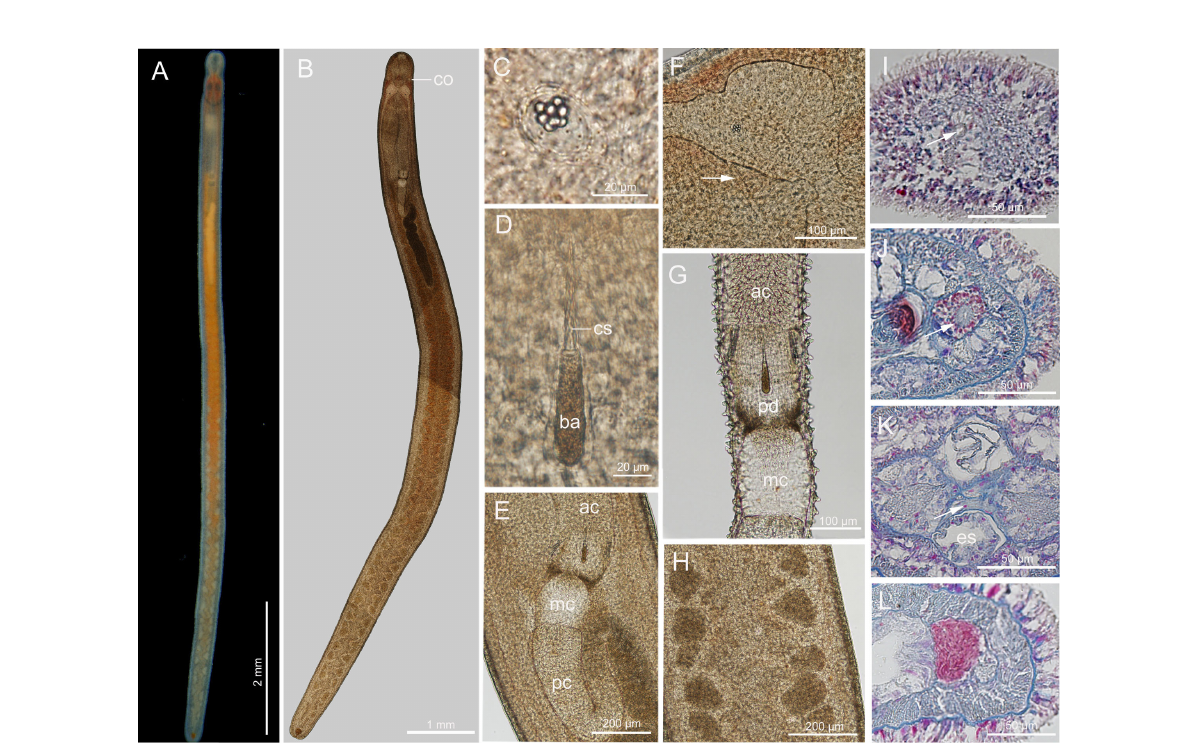
FIGURE 7 Ototyphlonemertes ( Procso ) subrubra sp. nov. (A) Photograph of a live specimen; (B) composite photomicrograph of a squeezed specimen; (C) statolith; (D) central stylet and basis; (E) photomicrograph of partial proboscis from a squeezed specimen; (F) photomicrograph of partial brain from a squeezed specimen, showing the extra ventral commissure (arrowed); (G) everted proboscis; (H, L) testes; (I) transverse section through frontal organ (arrowed); (J) transverse section through a cerebral organ (arrowed); (K) transverse section through cerebral region, arrow pointing to extra ventral commissure. ac, anterior chamber of proboscis; ba, basis; co, cerebral organ; cs, central stylet; es, esophagus; mc, middle chamber of proboscis; pc, posterior chamber of proboscis; pd, proboscis